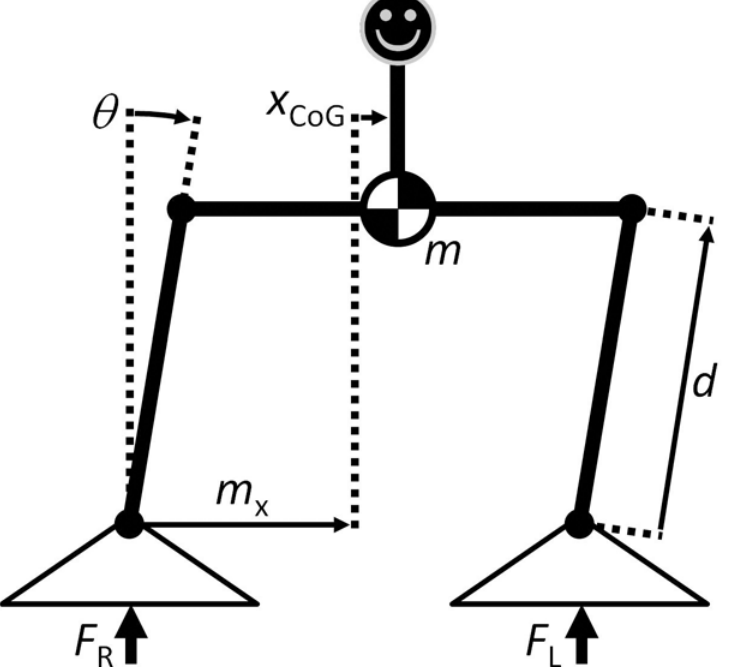
Fig 3. Parallelogram model. Model used for calculations for the CoP Mod feedback condition. In this model, θ is the estimated angular deviation of the subject ’ s CoM from neutral stance, m is the subject mass, x CoG is the lateral position of the CoM, F R is the vertical force exerted on the right foot, F L is the vertical force exerted on the left foot, d x is half the lateral distance between the centers of the two feet, and d y is the approximate distance between the subject ’ s hip and ankle (0.491 × subject height